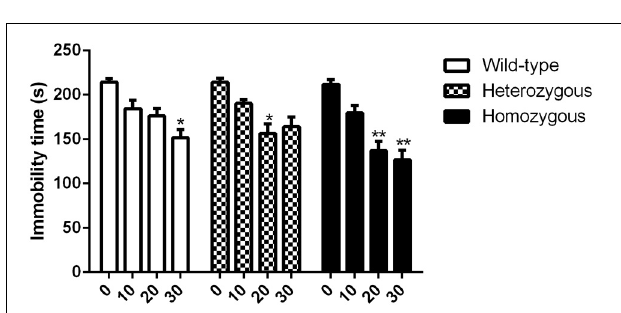
FIGURE 3 | Effect of imipramine on the immobility time of Wfs1-deficient mice in the FST. ∗ p < 0 . 05, ∗∗ p < 0 . 01 compared to vehicle-treated mice of the same genotype (Scheffe post-hoc test after significant Two-Way ANOVA). Altogether, 77 wild-type, 80 heterozygous, and 79 homozygousmice were used. Mice were randomly divided between respective study groups. Genotype [ F ( 2 , 224 ) = 5 . 9, p < 0 . 01]; treatment [ F ( 3 , 212 ) = 37 . 1, p < 0 . 01]; genotype × treatment [ F ( 6 , 224 ) = 1 . 7, p = 0 .